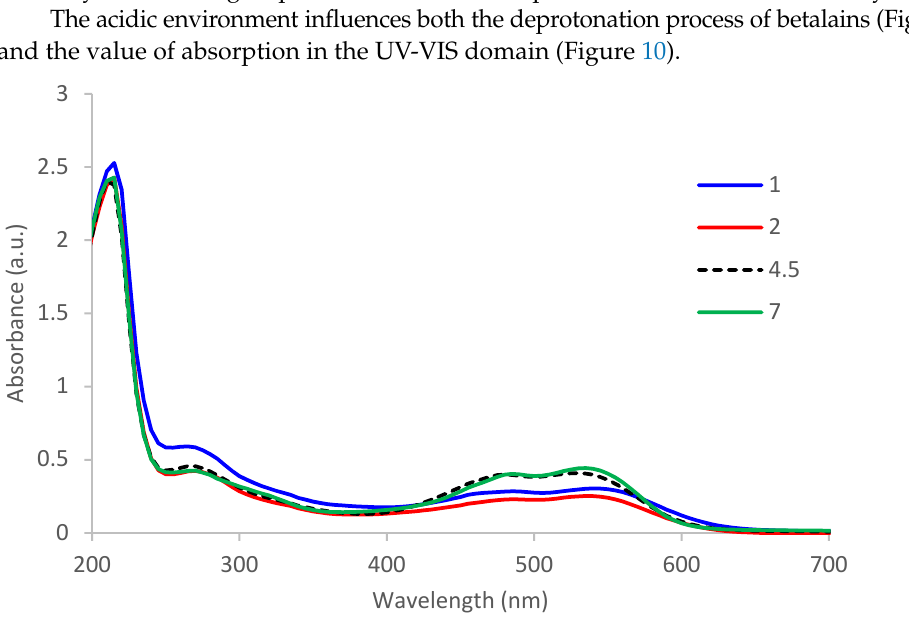
Figure 10. Influence of pH on absorbance of extract/betalains.